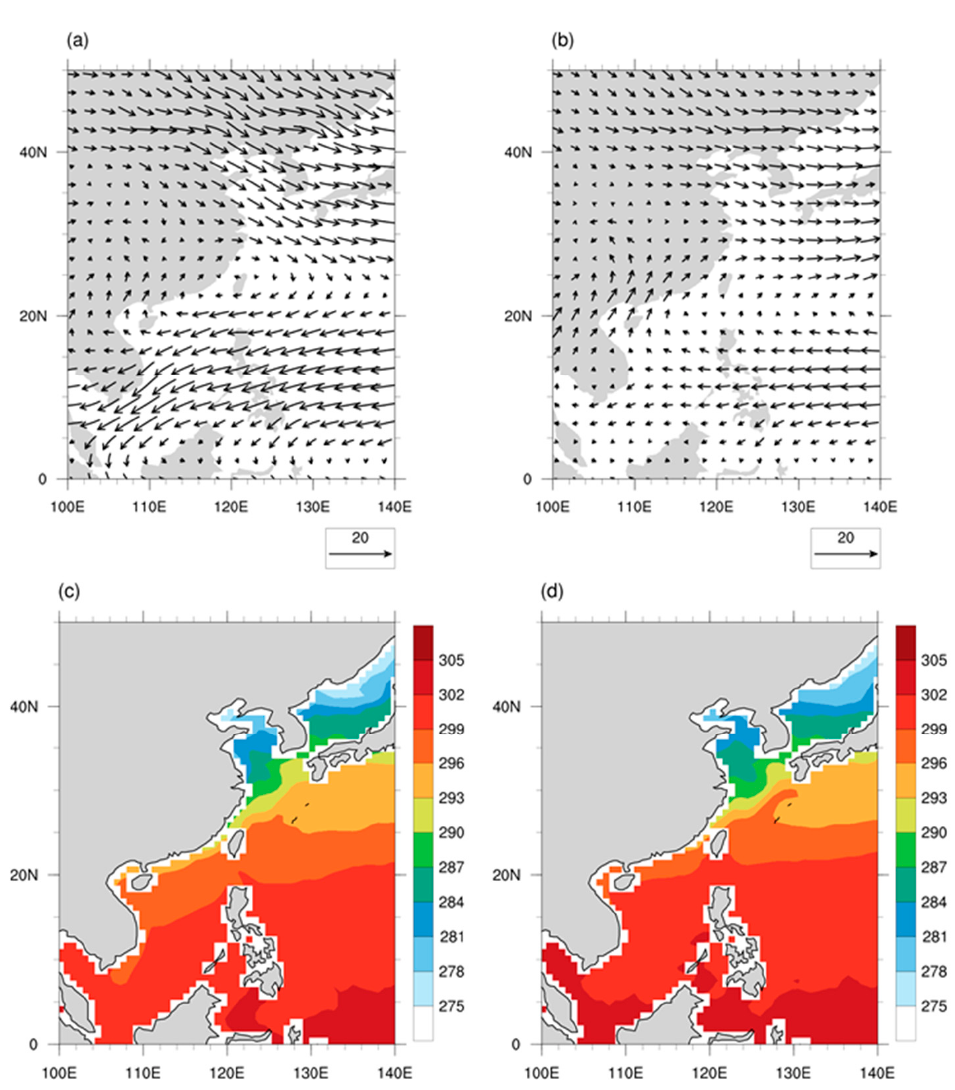
Figure 4. ( a , b ) The 2006–2010 DJF and MAM mean 850 hPa wind field, respectively. ( c , d ) The 2006–2010 DJF and MAM mean SST, respectively. These are ERA-Interim reanalysis